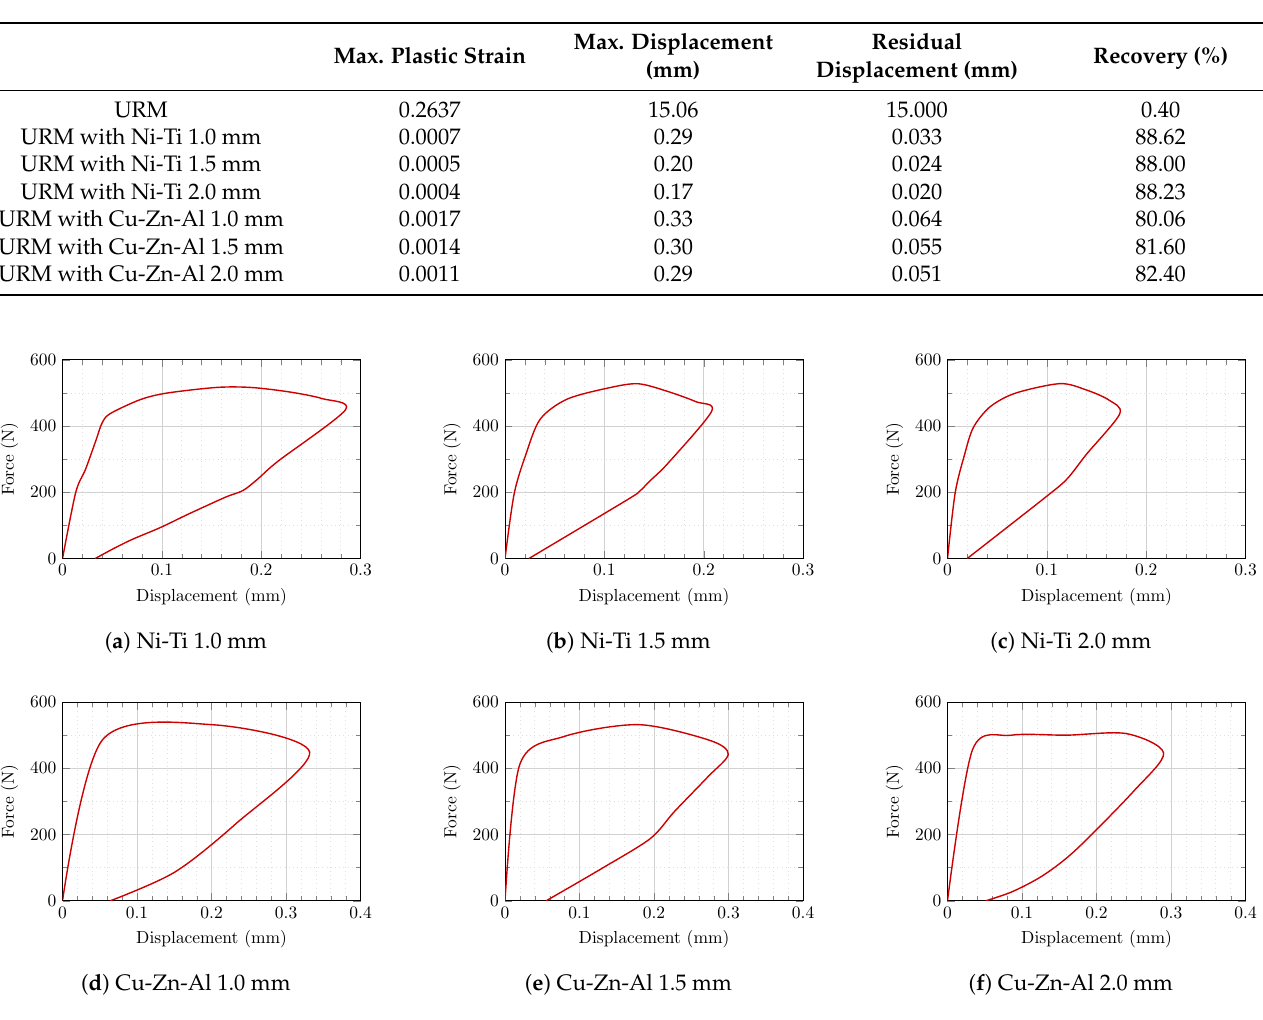
Figure 17. Relationship between reaction force at the support and mid-span displacement in retrofitted models: ( a ) 1.0 mm Ni-Ti; ( b ) 1.5 mm Ni-Ti; ( c ) 2.0 mm Ni-Ti; ( d ) 1.0 mm Cu-Zn-Al; ( e ) 1.5 mm Cu-Zn-Al; ( f ) 2.0 mm